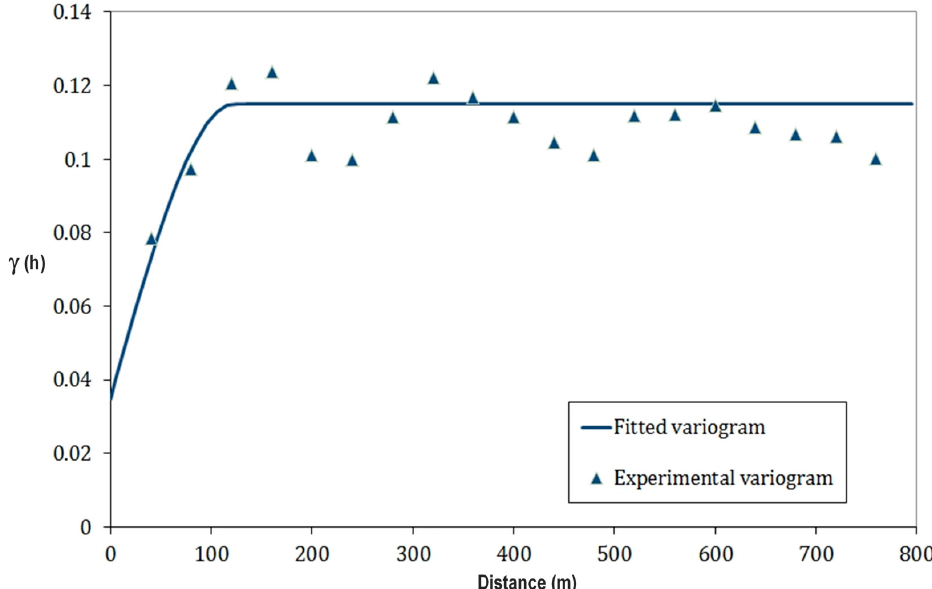
Figure 5. Variogram model fitted for the DSM error at control points located at streets. Triangles represent the experimental omnidirectional variogram. The black line is a spherical model of sill of 0.08, range 122 and a nugget effect of 0.035.